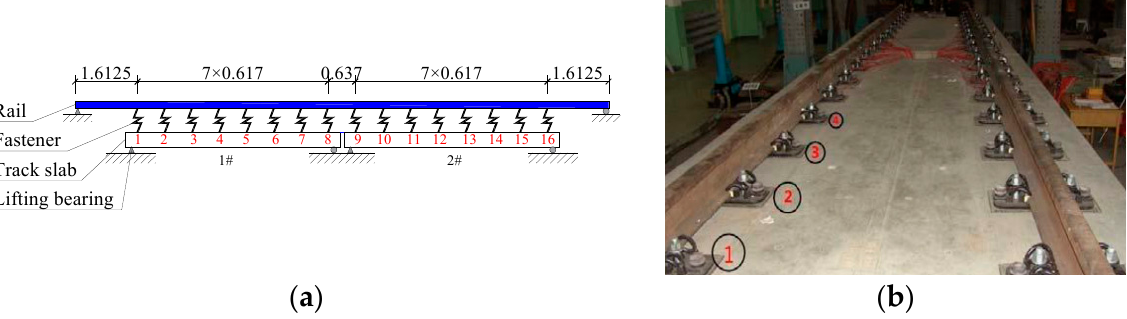
Figure 7. Schematic diagram of experimental model (unit: m): ( a ) Schematic diagram of fastener arrangement; ( b ) Photography of the experimental model. To study the effect of the vertical deformation amplitude of the bridge structure on the rail deformation and interlayer contact, AM-2 was used to analyze the track deformation for six amplitudes of girder vertical fault (see Figure 8): 0.5 mm, 1 mm, 3 mm, 5 mm, 10 mm, 15 mm.